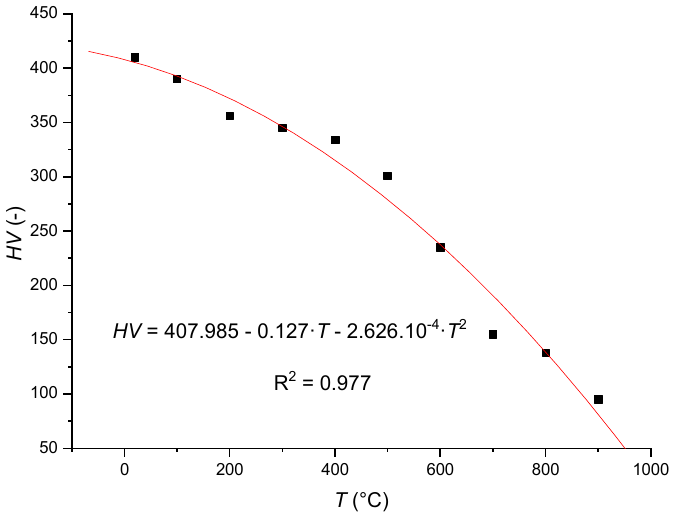
Figure 1. The nominal value of hardness of Stellite 6 spray in hot conditions.